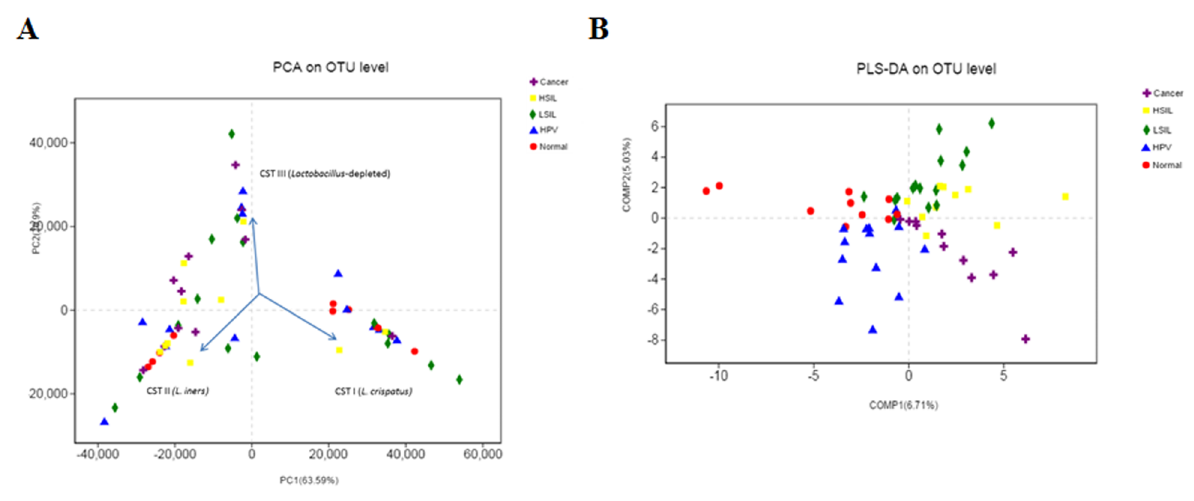
Figure 3 - Principal component analysis (PCA) of species sequence data and partial Least Squares Discriminant Analysis (PLS-DA) analysis of the high-dimensional data. (A) Principal component analysis (PCA) showed that the vaginal microbiota identified three major clusters L. crispatus (CST I), L. iners (CST II), and depleted of L. spp. with high diversity (CST III). (B) Partial least square discriminant score plot of vaginal microbiota between the normal, HPV, LSIL, HSIL and cancer